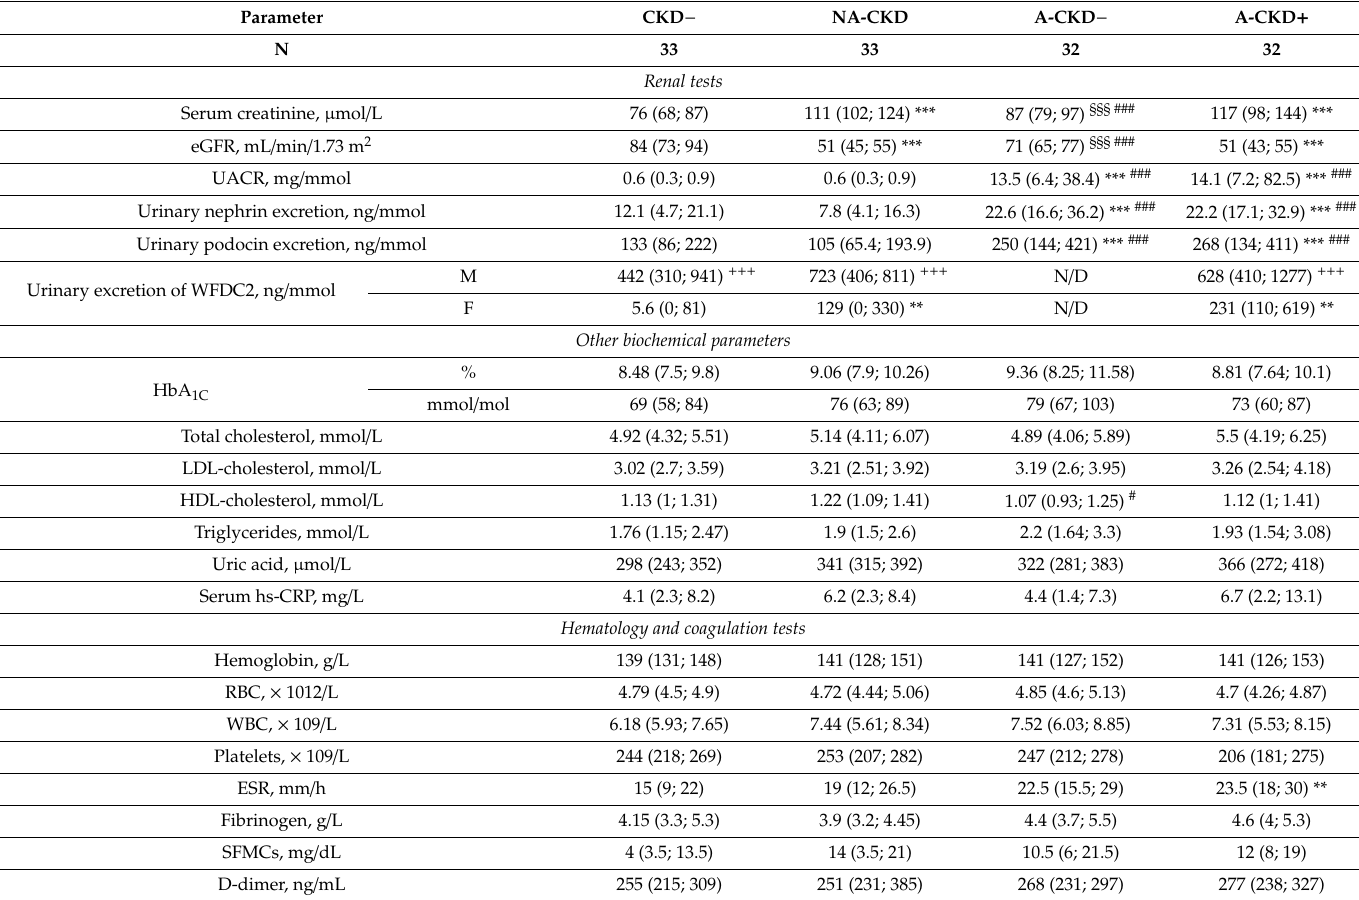
Table 2. Laboratory parameters in T2D patients with albuminuric and non-albuminuric